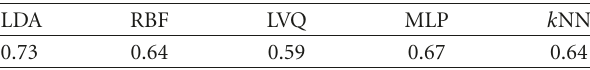
Table 2: Classification accuracy (percentage) obtained with the other